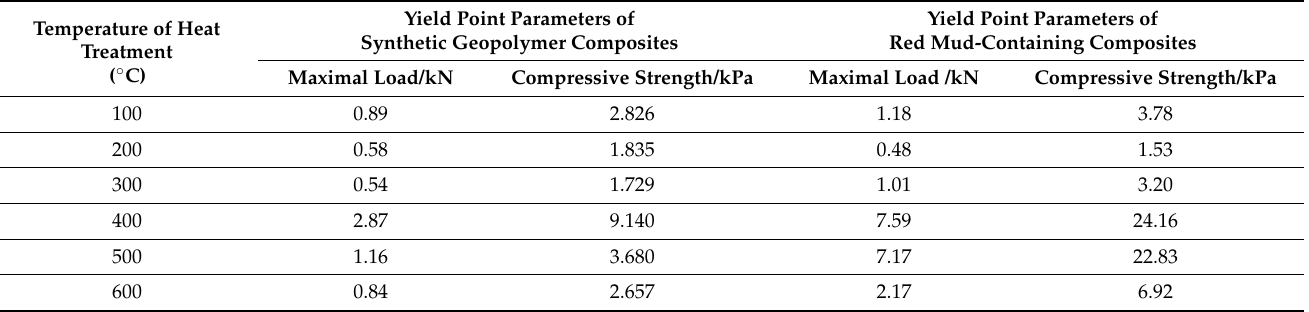
Figure 10. The load vs. time curves of the MTS compressive strength measurement of the red mud- containing composite heated at 100–300 °C and 400–600 °C.